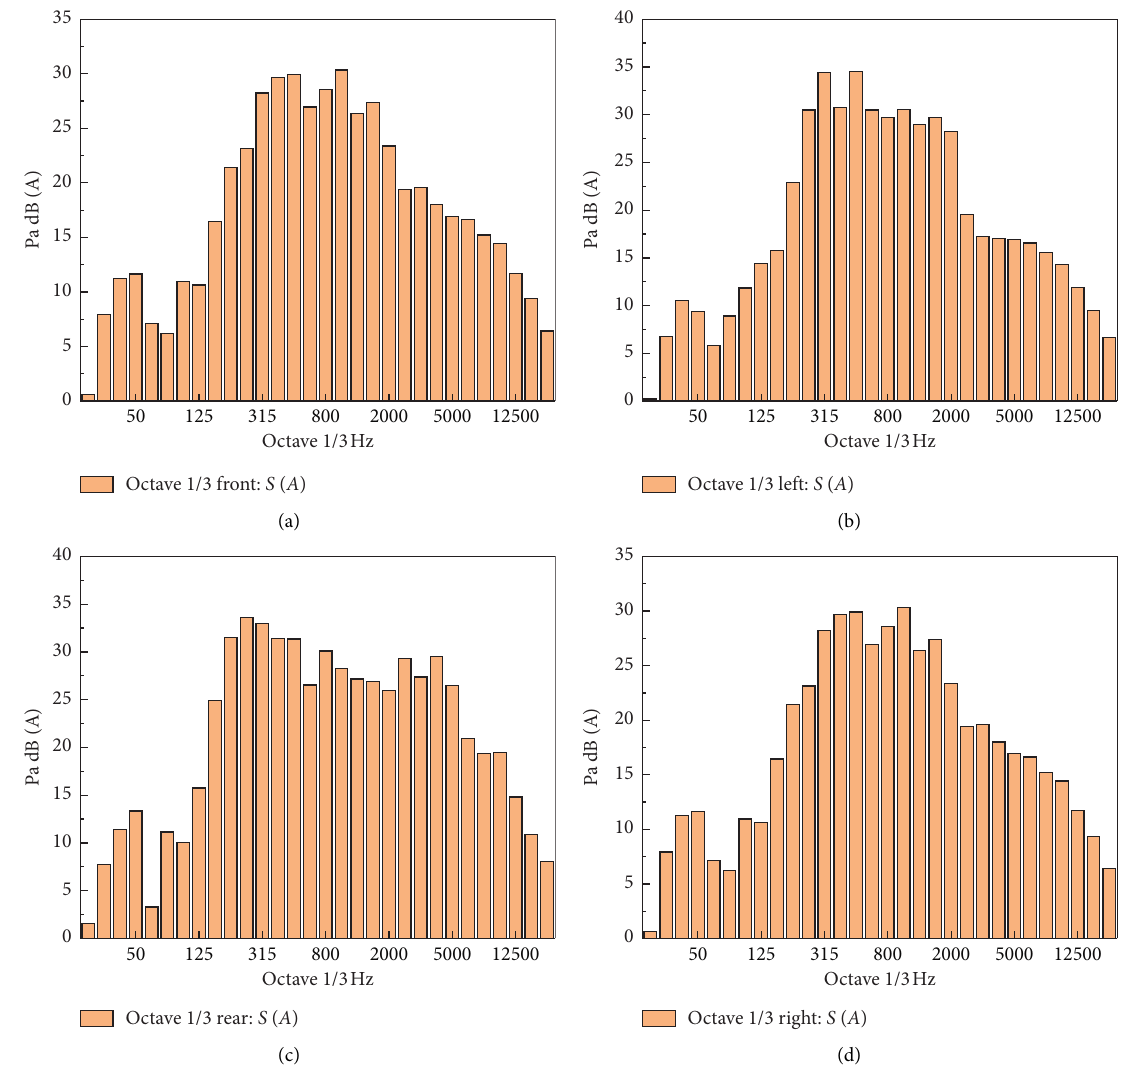
Figure 1: Distribution of the noise spectrum of the refrigerator in four